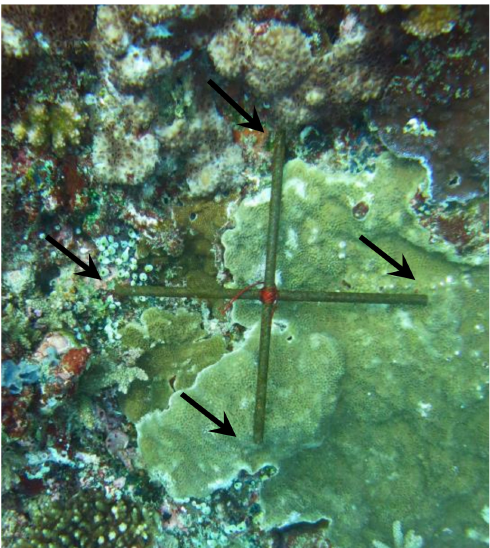
Figure A2. The steel-bar cross used to characterize the benthic cover at parrotfish bites. The intersection point was placed at the bite and substrate underneath the intersection point and at each end of the arms were noted, in order to characterize bite selectivity. Each arm is 25 cm.